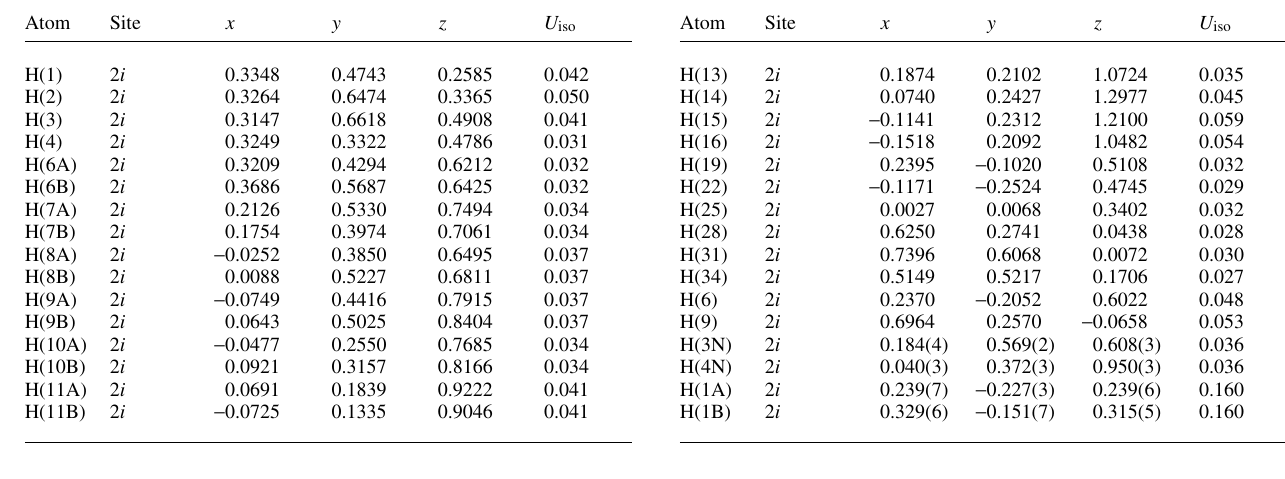
Table 3. Atomic coordinates and displacement parameters (in Å 2 ) .